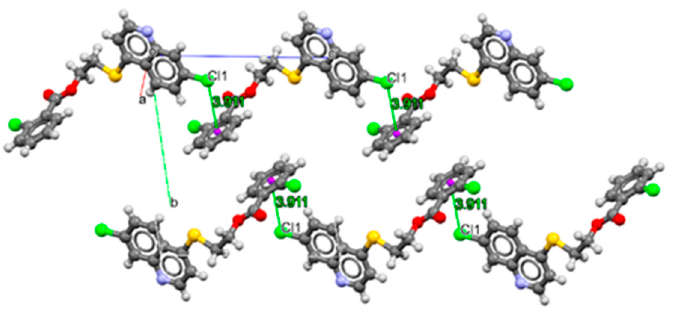
Figure 9. View of the C1-Cl1, …, Cg3 interactions.